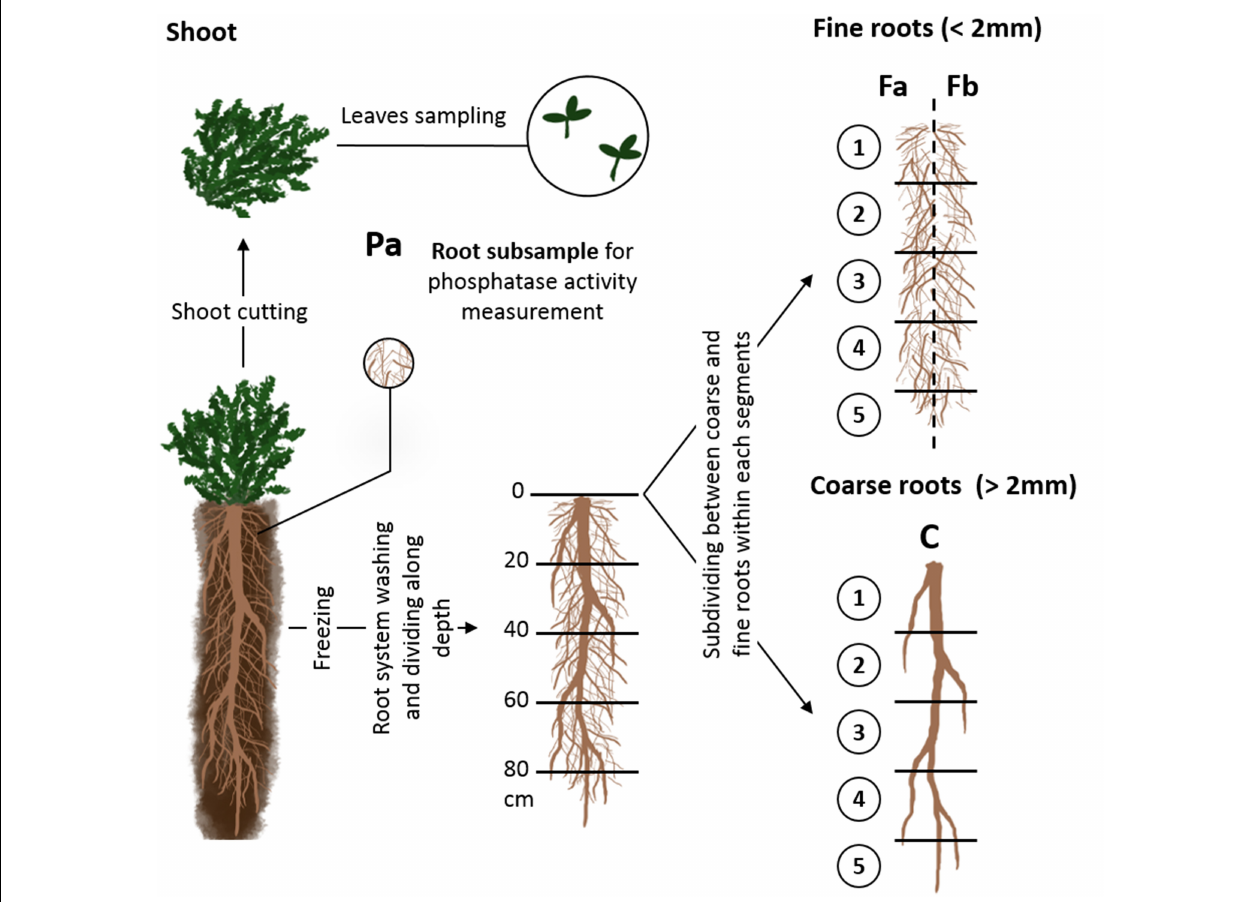
FIGURE 1 | Illustration of the successive steps of sampling during the experiment. C: coarse root fraction; Fa and Fb two halves (fresh weight basis) of fine root fractions of each soil segments; Pa: root sample for phosphatase activity measurements.